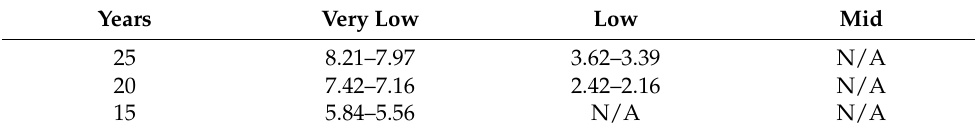
Table 17. BEIS Range of Balance Model.